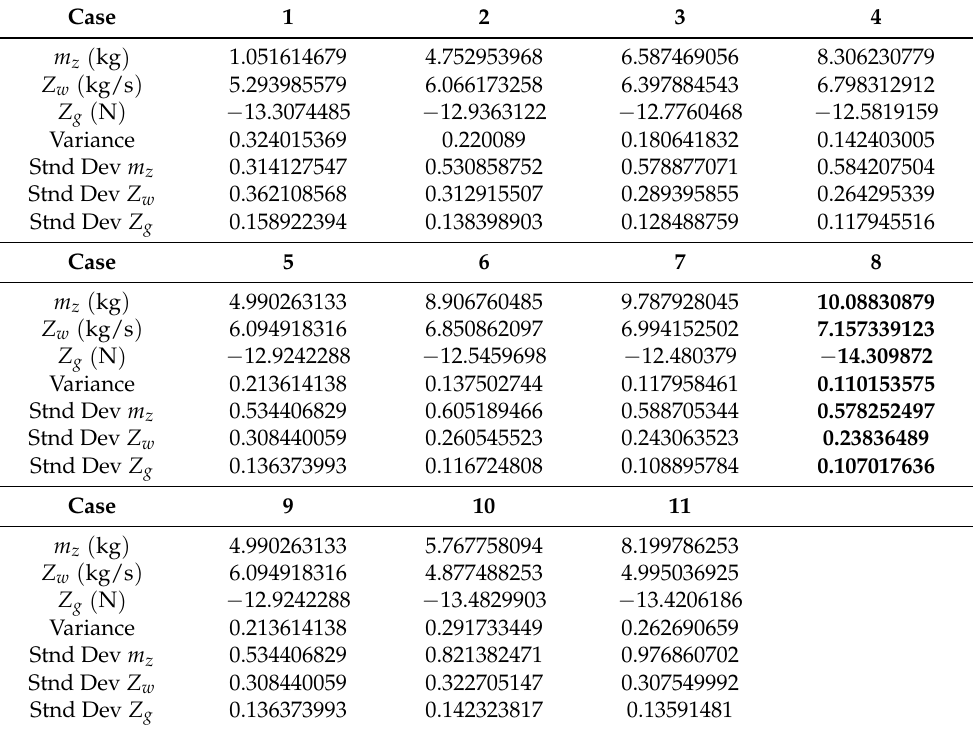
Table A5. Results of the estimation of hydrodynamic parameters for the positive motion in b z with 150 iterations.